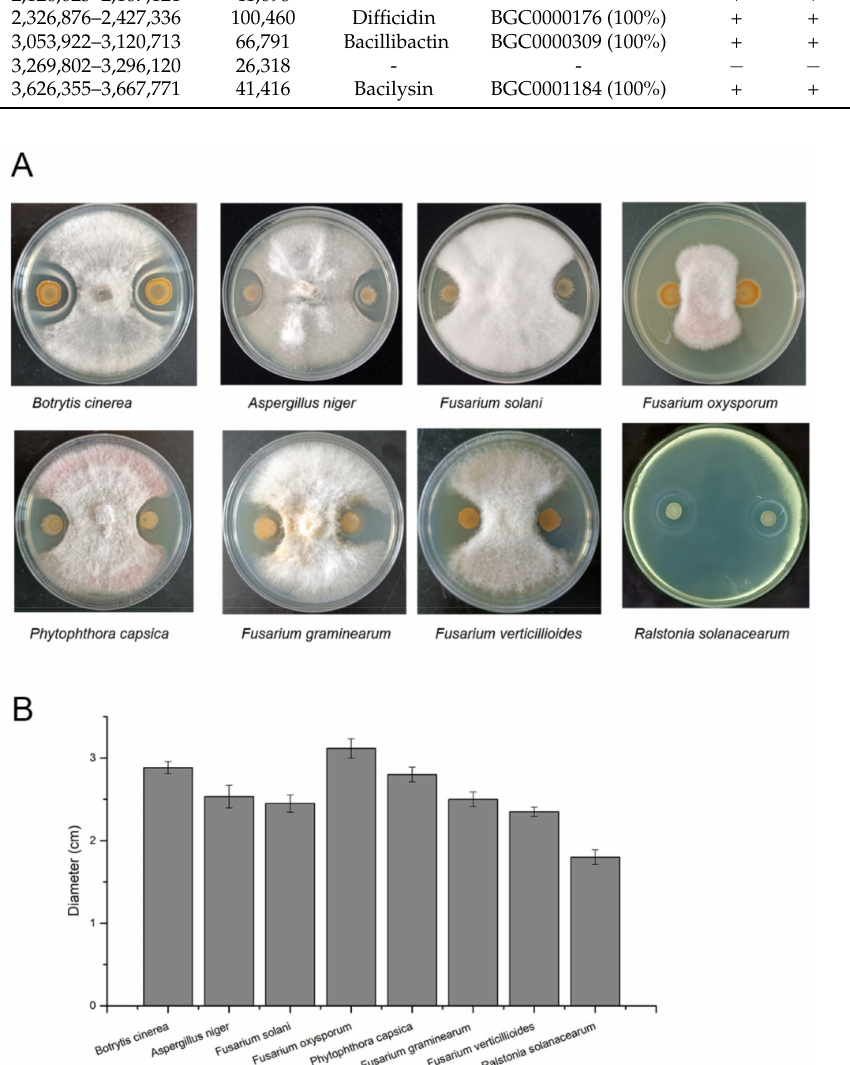
Figure 5. Antagonistic activity of strain SC60 against eight plant pathogens. ( A ) Inhibition effect of strain SC60 on the growth of plant pathogens. ( B ) The size of the zone of inhibition. Error bars indicate the standard deviations based on six independently replicated